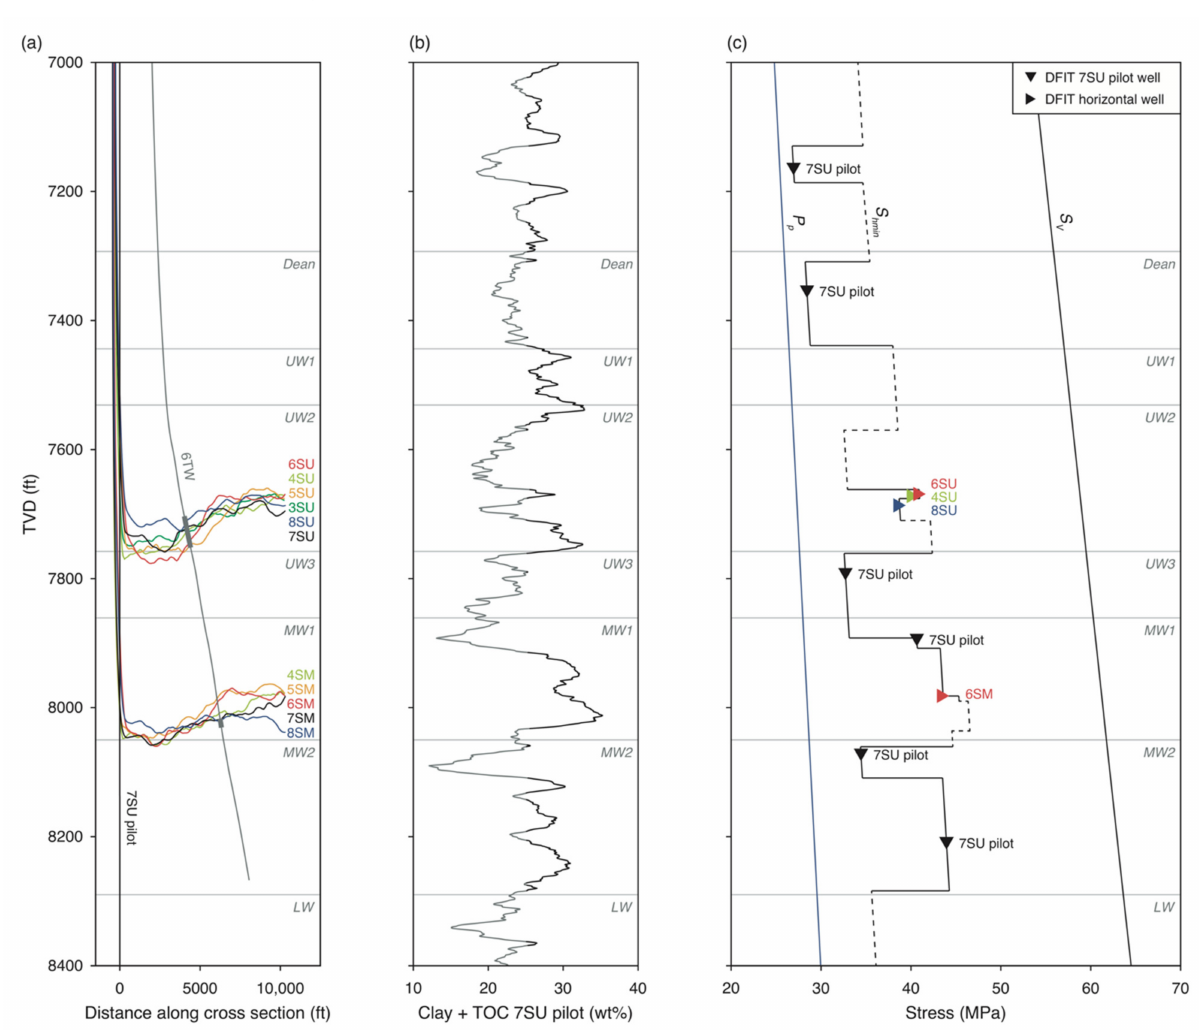
Figure 4. ( a ) Well trajectories in cross section shifted according to stratigraphic depth with respect to the pilot well (Figure A1). ( b ) Clay + total organic carbon (TOC) as a function of depth. Regions with clay + TOC exceeding 25 wt% are highlighted in black. ( c ) Stress, mudweight, and pore pressure as a function of depth. Measurements of S hmin include DFITs from the vertical pilot well and horizontal wells. Stress measurements in both the Upper and Middle Wolfcamp are shifted according to stratigraphic depth with respect to the pilot well. The black line is the interpreted stress profile based on stratigraphically shifted stress measurements and is dashed in the regions with no